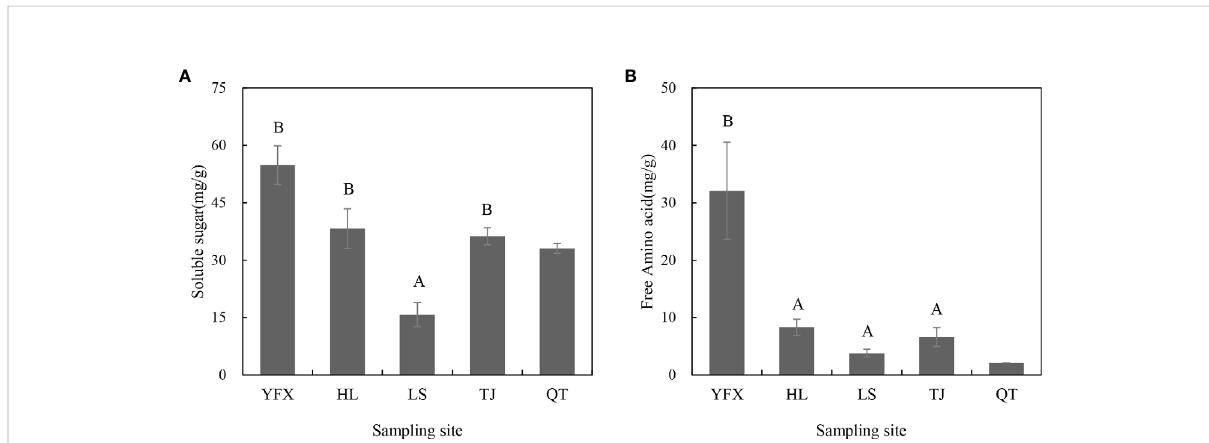
FIGURE 2 Souble sugars (A) and free amino acid (B) content of seagrass plant in fi ve areas. Different letters above bars indicate signi fi cant differences ( p <0.05) among regions. Values represent mean ± S.E. Due to the lack of sample size of QT, variables just have one or two values.